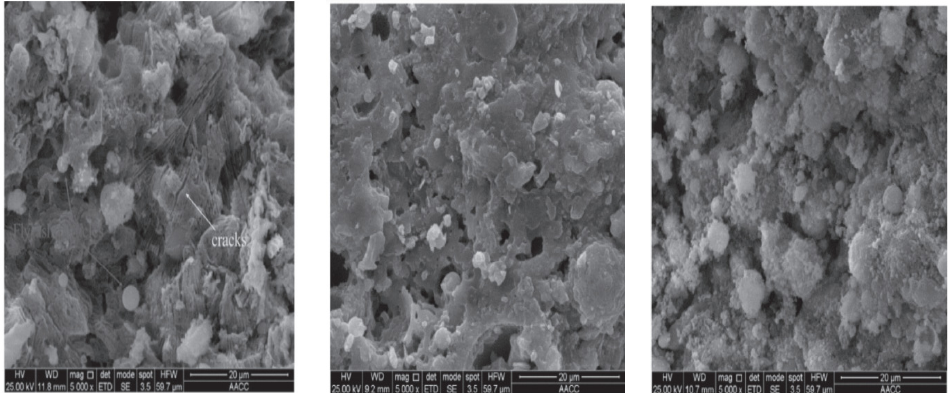
Figure 15. SEM of FLGC NaOH Contents, i.e., 5%, 10%, and 15% [91]. (Reprinted with permission from the publisher, Elsevier; License No. 547171129494). from the publisher, Elsevier; License No. 547171129494).